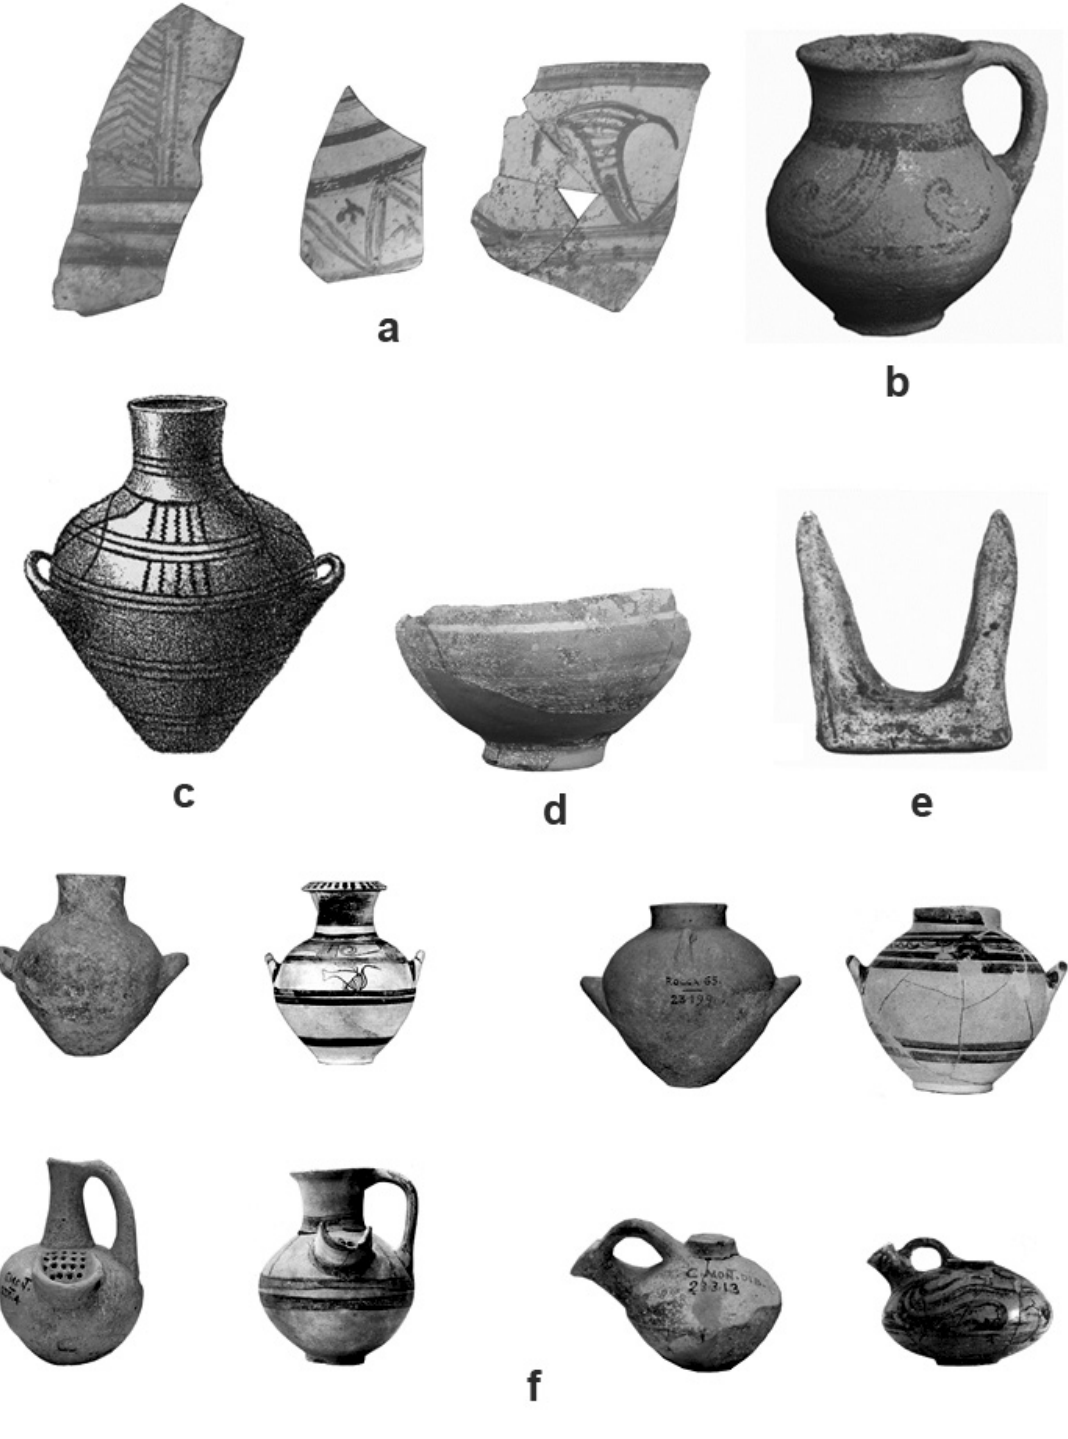
Figure 6: a) Late Helladic IIIB-Pottery from Lipari (Voza, 1985); b) Late Helladic IIIC type juglet from tomb 133 North of Pantalica (Tanasi, 2009); c) Sub-Mycenaean type amphora from Lo Curzio tomb at Pantalica (Tanasi 2009); d) Bowl of Late Cypriote III type from Capreria (Castellana, 2000); e) Terracotta model of a pair of horns inspired by Late Minoan prototypes from the territory of Catania (La Rosa et al., 2002); f) Shapes from the North Pantalica pottery repertoire (left: amphora, strainer spouted jug, hydria, askos) and their Aegean models (on the right) (Tanasi,